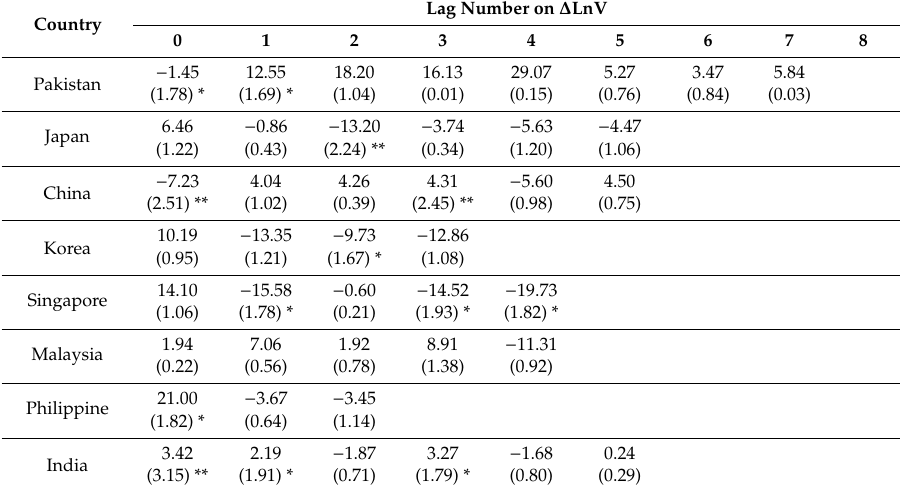
Table 1. Short-Run Coe ffi cient Estimates of Volatility on Exports: Estimates from the linear Export Demand Model (3). Lag Number on ∆ LnV Country 0